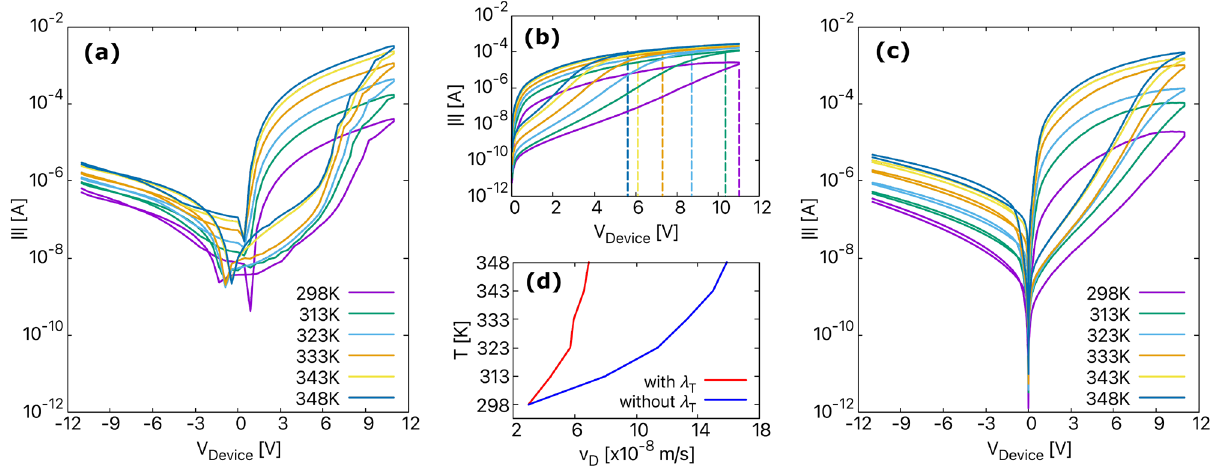
Figure 6. ( a ) The experimentally obtained temperature-dependent current–voltage characteristics ( I – V – T curves). ( b ) Simulated I – V – T curves obtained using the fitting parameter ( (cid:31) T ). The parameters used in the simulation are given in Table 3. ( c ) I – V – T curves obtained for positive applied voltage and without (cid:31) T . The dashed lines indicate the voltage required to switch the device from HRS to LRS. The legend is same as mentioned in ( b ). ( d ) The calculated average drift velocity ( ν D ) with and without (cid:31) T at different